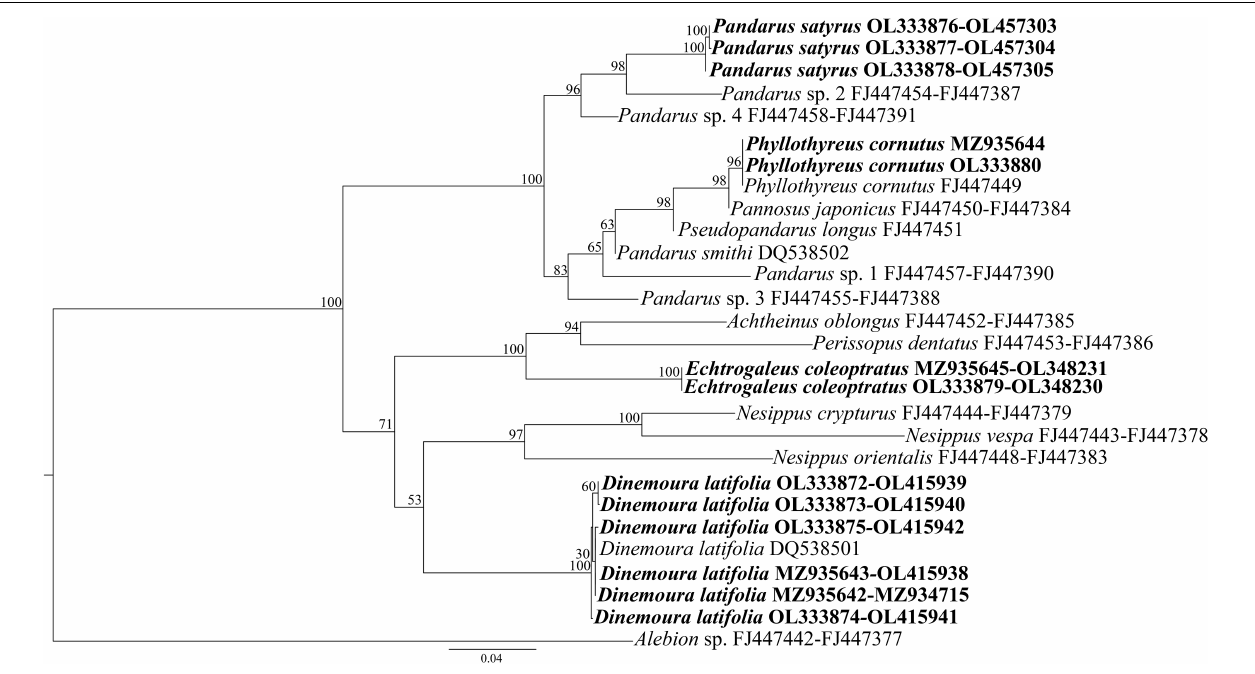
FIGURE 2 | Phylogenetic concatenated tree from maximum likelihood based on SSU and cox 1 sequences of pandarid species obtained in the present study, with respect to the pandarid sequences at the same gene loci available in GenBank. Alebion sp. was used as outgroup. The sequences obtained in this study are in